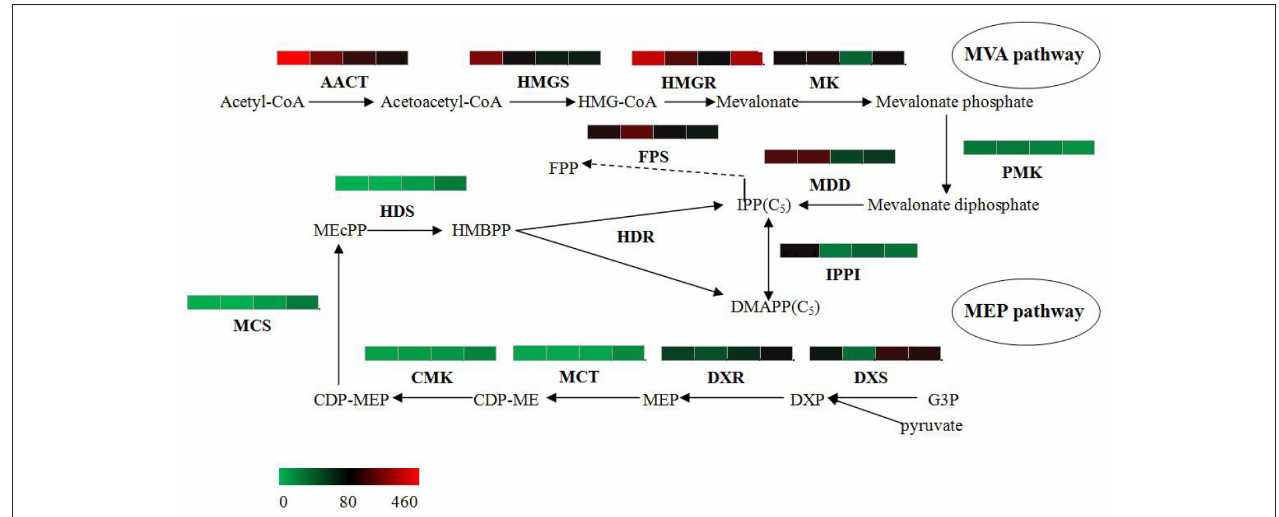
FIGURE 4 | Putative IPP and DMAPP biosynthesis in Periploca sepium. Enzymes involved in IPP and DMAPP biosynthesis from the MVA and MEP pathways are shown. The expression of genes encoding these enzymes in AR, C, R, and L are shown by the heat-map. These genes were mapped using RPKM values, and they were color coded by increasing relative expression. IPP, isopentenyl diphosphate; DMAPP, dimethylallyl diphosphate; MVA, mevalonic acid; MEP, methylerythritol phosphate; ACAT, acetyl-CoA acetyltransferase; HMGS, HMG-CoA synthase; HMGR, HMG-CoA reductase; MK, mevalonate kinase; PMK, phosphomevalonate kinase; MDD, mevalonate diphosphate decarboxylase; FPS, farnesyl diphosphate synthase; IPPI, isopentenylpyrophosphate isomerase; DXS, DXP synthase; DXR, DXP reductoisomerase; MCT, MEP cytidylytransferase; CMK, CDP-ME kinase; MCS, MEC synthase; HDS, HMBPP synthase; HDR, HMBPP